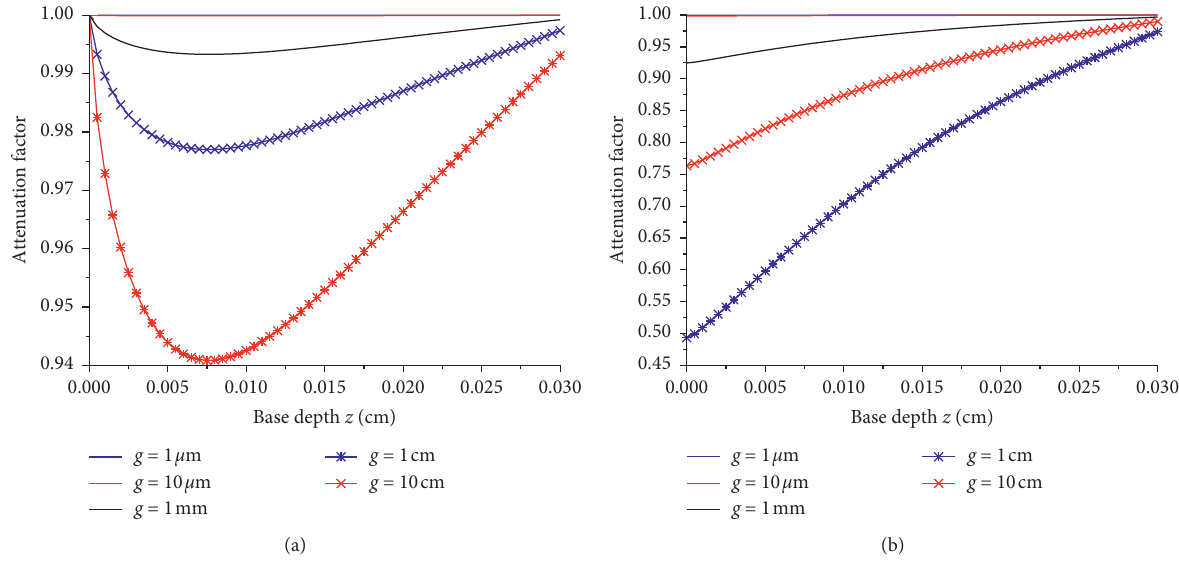
Figure 4: Attenuation factor of radio wave versus base depth for different grain sizes in short circuit (a) and open circuit (b) ( S gb � 10 3 cm s − 1